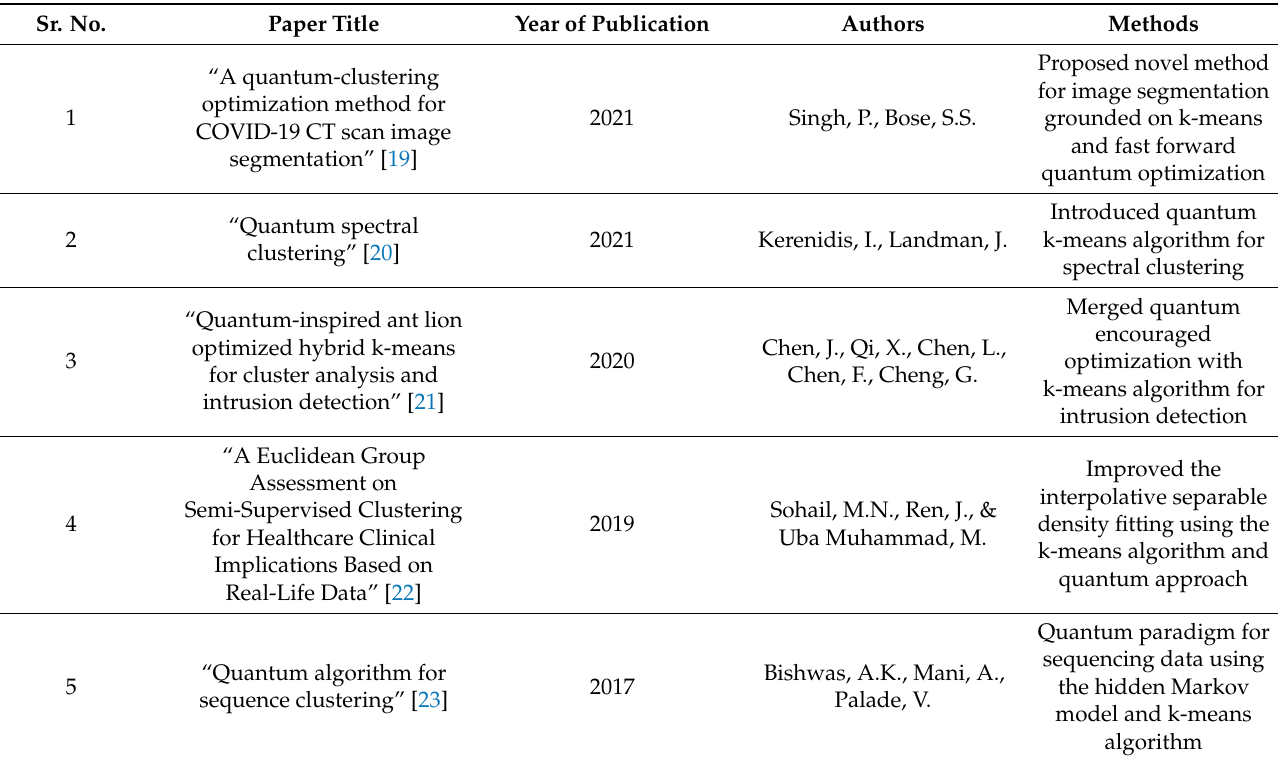
Table 1. Summary of existing variants of hybrid k-means quantum algorithm. Sr.